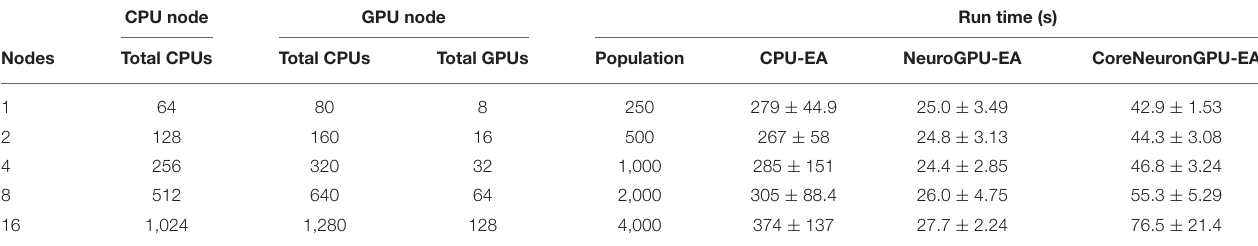
TABLE 3 | Compute scales and problem scales: see Table 2 for other details. CPU node GPU node